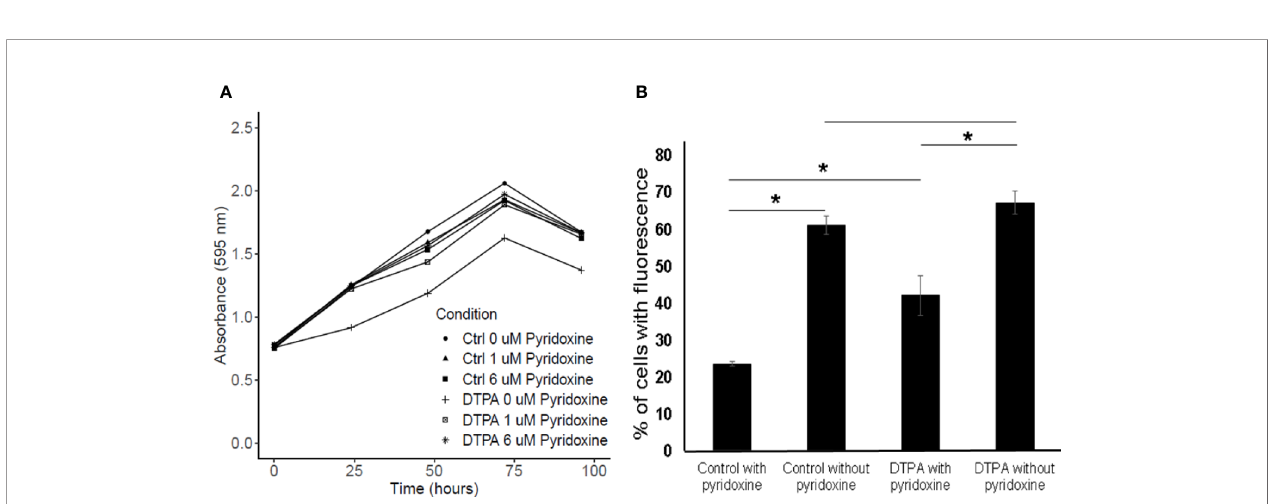
FIGURE 8 | In fl uence of pyridoxine on H. capsulatum growth and oxidative stress level. (A) Growth curve of H. capsulatum during zinc deprivation at different concentrations of pyridoxine. (B) ROS detection of H. capsulatum labeled with DCFH-DA. Ctrl, fungal cells grown in zinc; DTPA, fungal cells grown in DTPA. All experiments were carried out in biological triplicates. The comparison was made using the Student t test with *p ≤ 0.05. number of labeled cells by twofold. The zinc limitation in absence of pyridoxine potentialize the ROS levels since teh number of labeled cells incresed by threefold. Therefore, it may be concluded putatively related to zinc homeostasis in H. capsulatum . Two that both pyridoxine and zinc are able to in fl uence H. capsulatum ’ s of them are transcription factors (Zap1 and PacC), three belong ability to control intracellular ROS levels ( Figure 8B ).